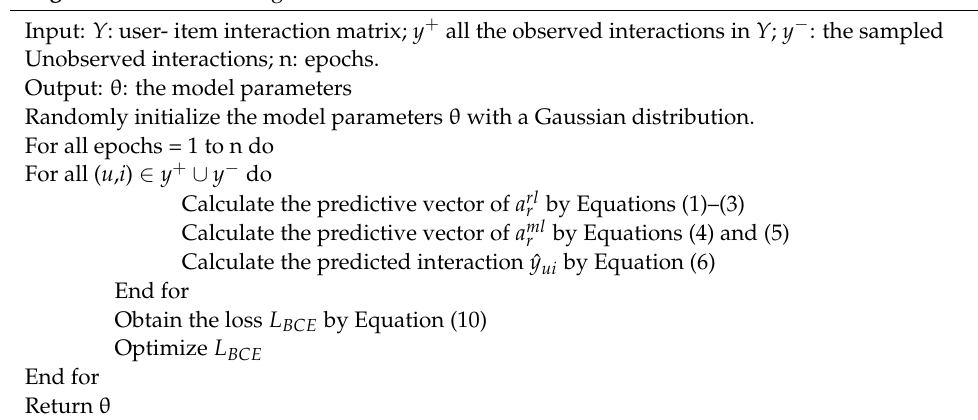
Algorithm 1. The training of DACR